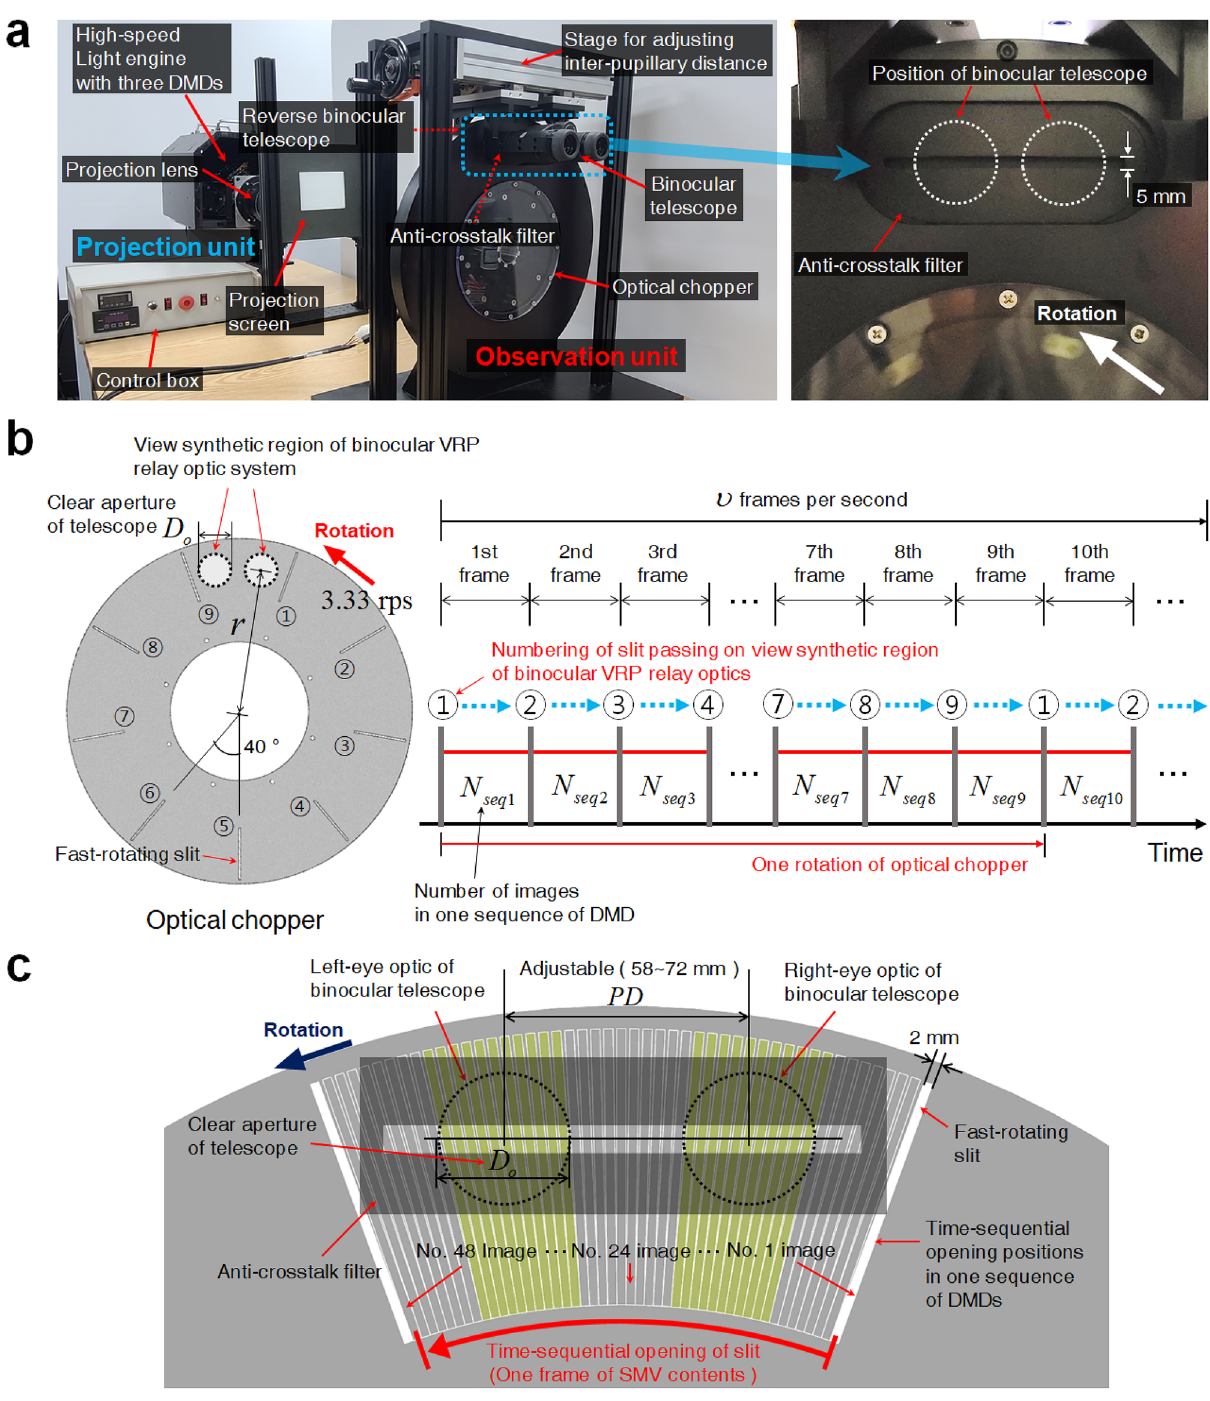
Figure 3. Proposed BTS HDSMV projection system. ( a ) Experimental setup for the projection unit of the devised BTS HDSMV projection. The fast-moving slit in Fig. 2 is implemented using an optical chopper with nine slits. ( b ) Synchronization between the rapidly rotating slit of the optical chopper and the frames of the DMDs. ( c ) Configuration for a single frame of an SMV